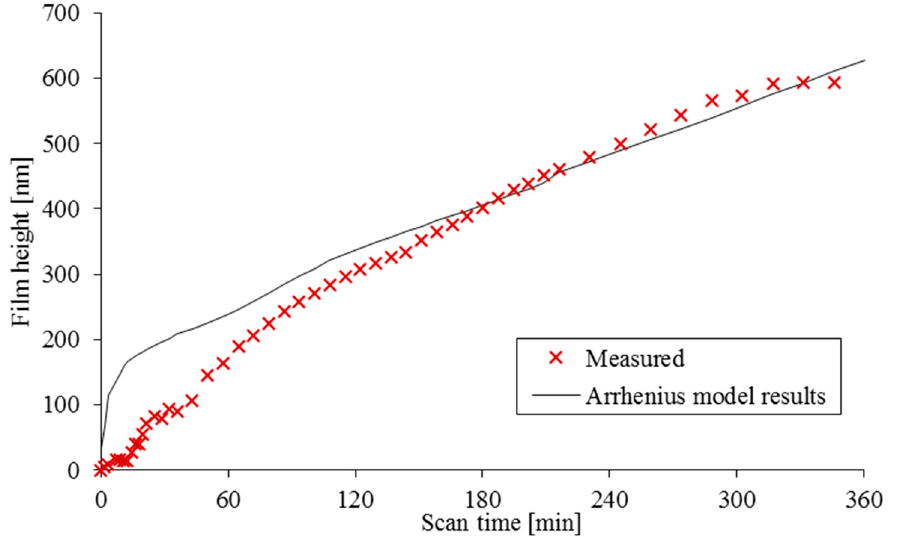
Figure 5. Comparison of the predictions of the Arrhenius shear promoted thermal activation model with the experimental measurements.